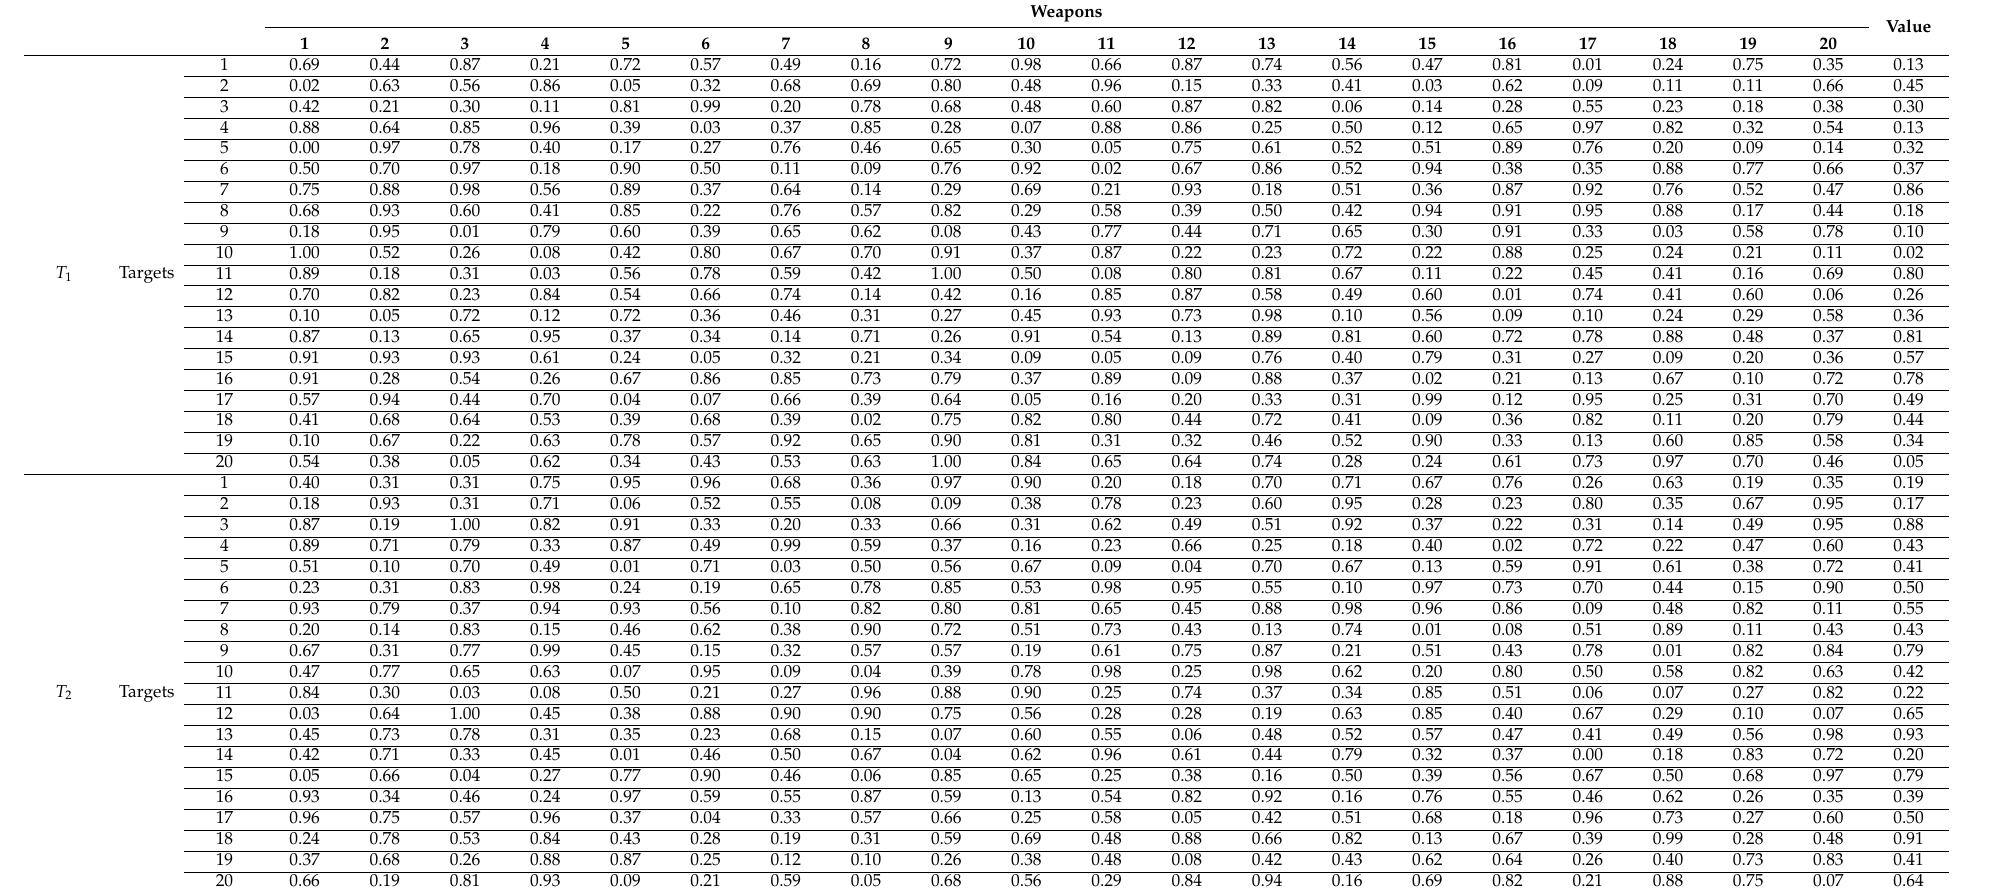
Table A4. Details of the destructive value of every target and the probability of kill for every weapon in the two component tasks of problem 3 in Table 2. Each task is a WTA